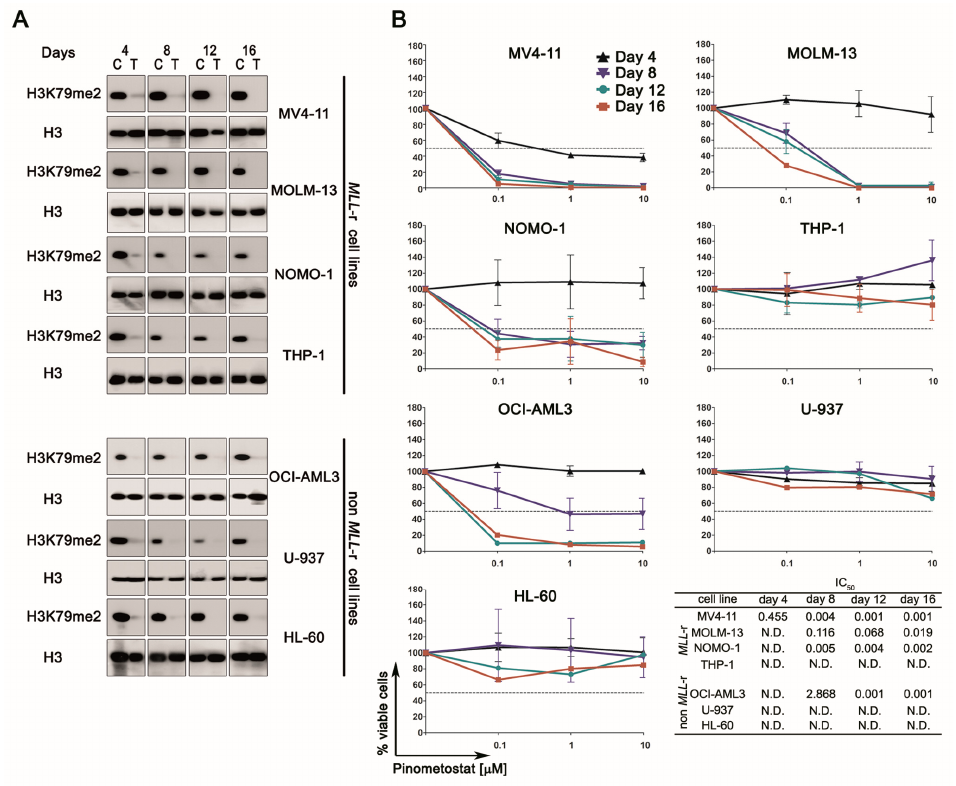
Figure 1. Pharmacological targeting of DOT1L in human acute myeloid leukemia (AML) cell lines with or without mixed lineage leukemia rearranged ( MLL -r). ( A ) Western blotting analysis of histones isolated from MLL -r and non- MLL -r AML cell lines treated with 1 µM of Pinometostat or DMSO 0.01%. H3K79me2 levels were analyzed every 4 days for a period of 16 days. Molecular weights are indicated on the right. C: control cells; T: treated cells. ( B ) Growth curves of MLL -r and non- MLL -r AML cell lines treated with increasing concentrations of Pinometostat or DMSO 0.01% as vehicle control for up to 16 days and summary of IC 50 concentrations. Results of three independent replicates are presented as means ± SD.